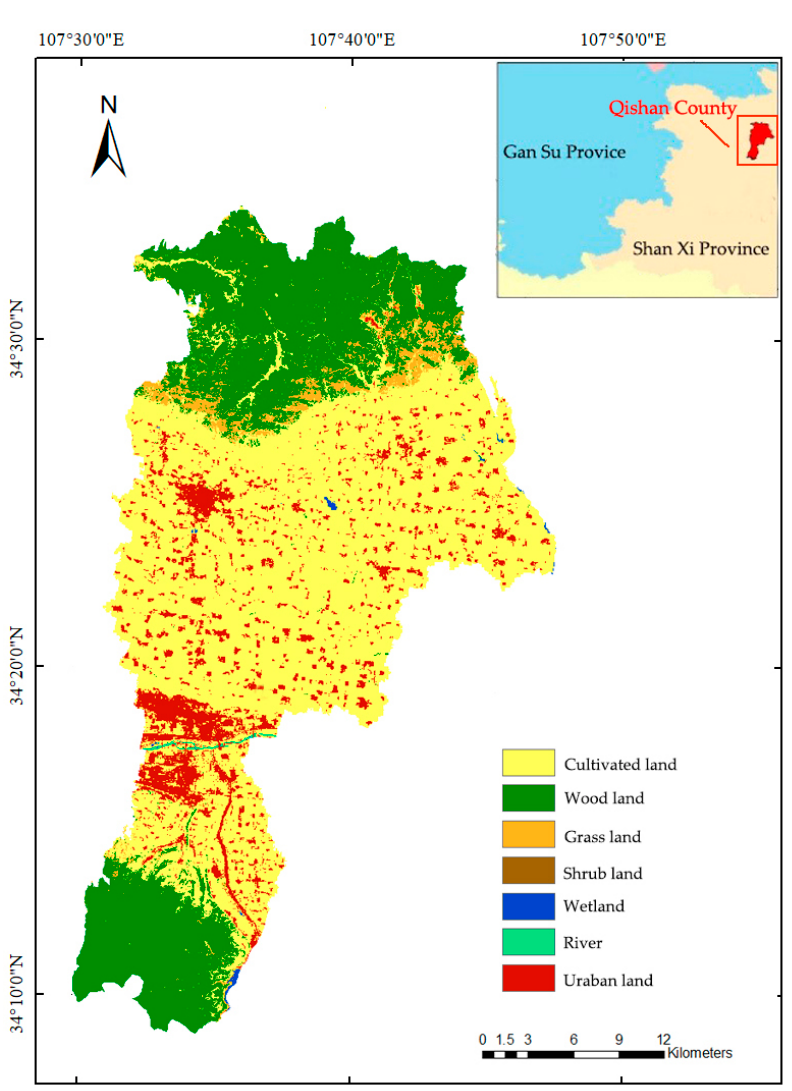
Figure 1. Geographical Location of Qishan County (2020).